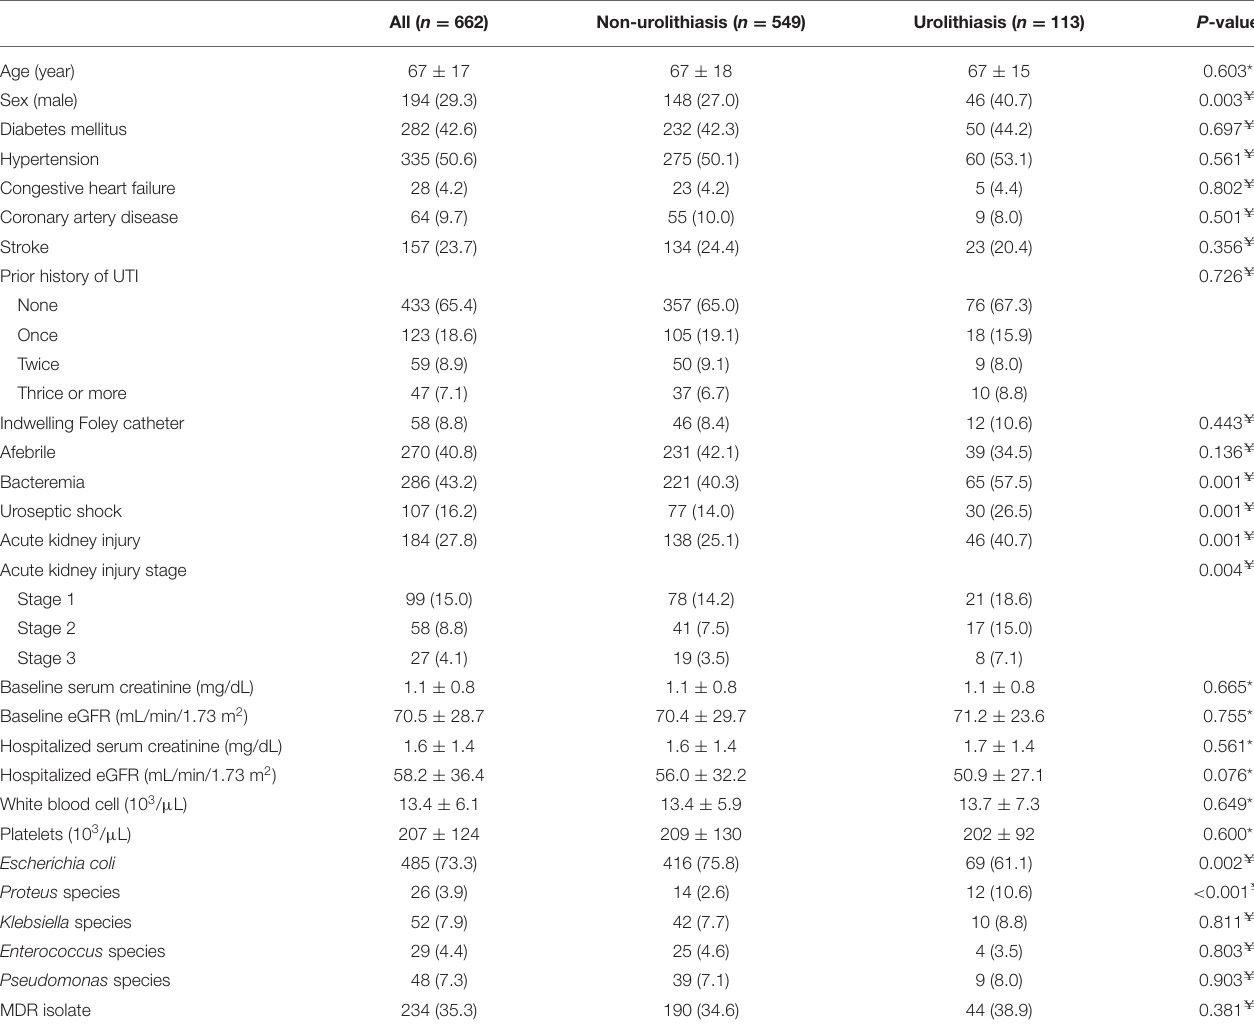
TABLE 1 | Characteristics of hospitalized patients with urinary tract infection with respect to urolithiasis. All ( n = 662) Non-urolithiasis ( n = 549) Urolithiasis ( n = 113) P